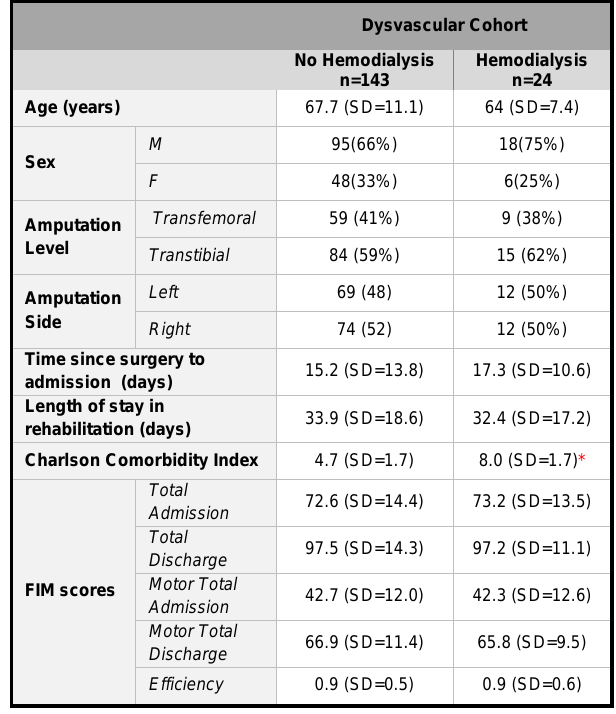
Table 1: Cohort description.